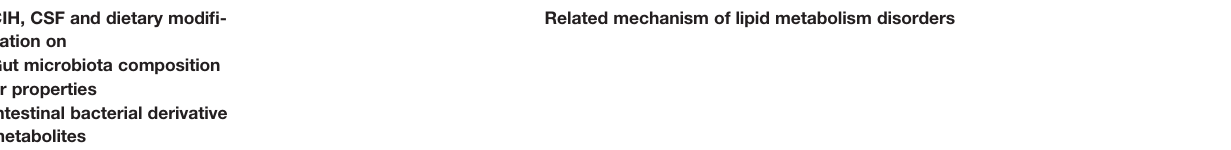
TABLE 1 | Commonalities between CIH and CSF (with or without HFD-fed) related modi fi cation on lipid metabolism through gut microbiota-metabolite-liver/adipose axis. CIH, CSF and dietary modi fi - cation